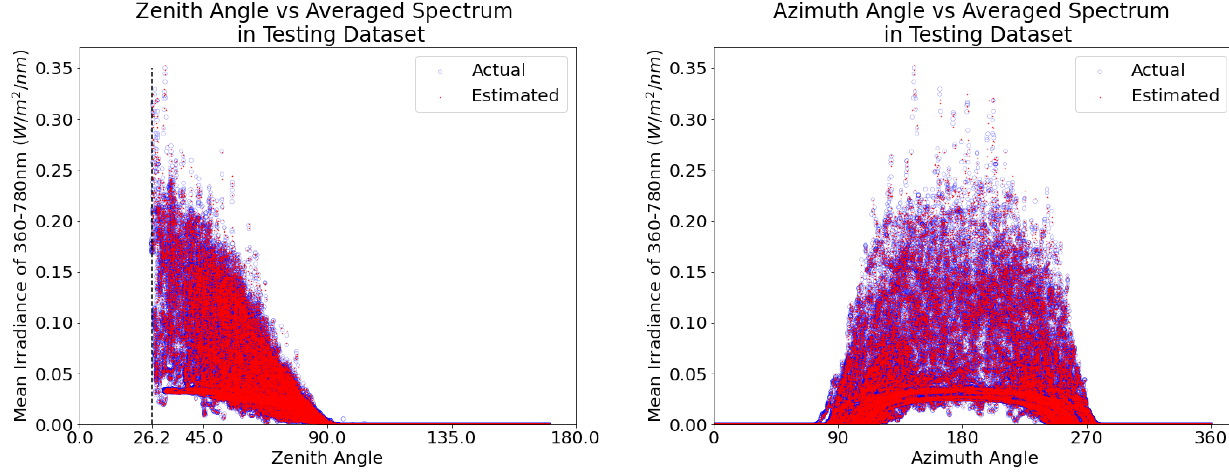
Figure 11. The mean irradiance from 360–780 nm as a function of solar zenith angle ( left panel ) and solar azimuth angle ( right panel ) from the testing data set for the entire three month period. The blue circles show the actual irradiance; the overlaid red points show the machine learning estimates. We observe that the surface irradiance observed by the reference sensor and that is estimated by the low-cost ensemble of sensors calibrated using machine learning agree very well; the blue and red points overlay one another so precisely that they produce the appearance of magenta points. In each panel, the solid curves close to the bottom shows the averaged irradiance for the sunny days, and the cloudy days produce higher values of irradiance due to the trapping of photons by multiple scattering from the clouds and surface reflection of the scattered light.